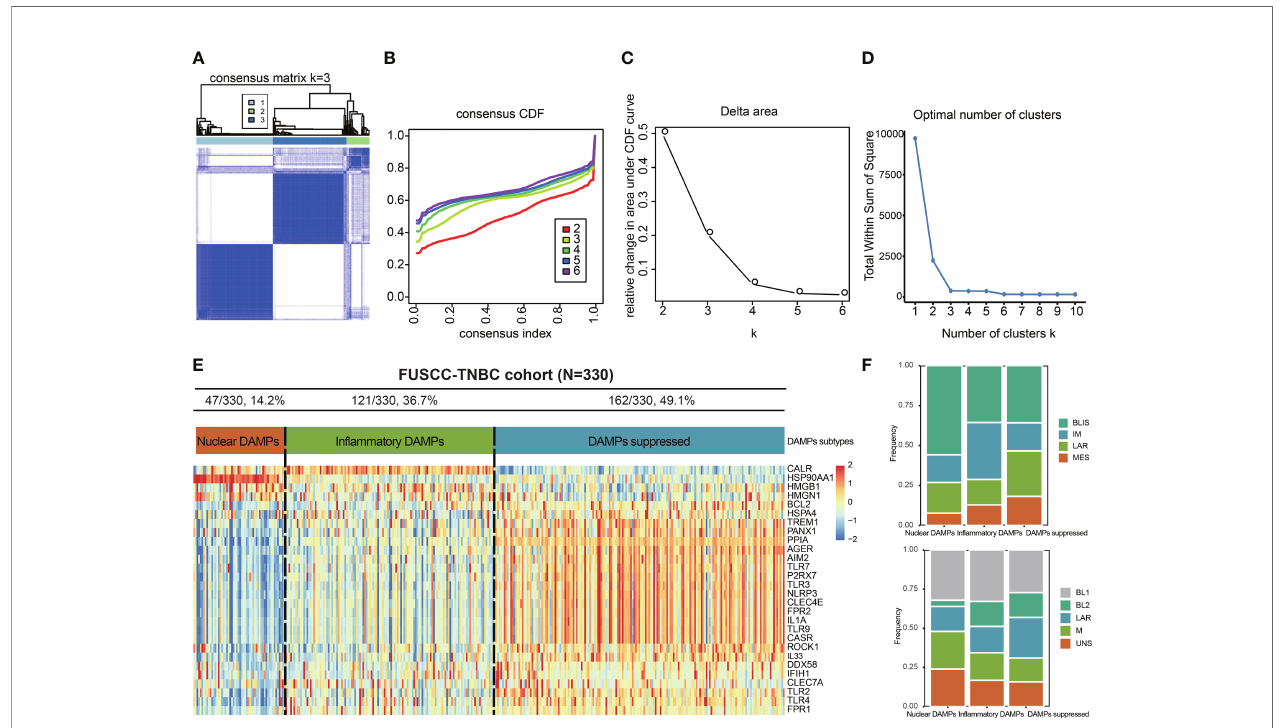
FIGURE 2 | Identi fi cation of DAMPs-associated subtypes by K-means analysis. (A-C) K = 3 was identi fi ed as the optimal value for consensus clustering. (D) K = 3 was identi fi ed as the optimal value for cluster sums of squares. (E) DAMPs-associated subtyping of TNBC samples (n = 330) in the FUSCC cohort. Heatmap shows normalized enrichment scores of the three DAMPs-associated subtypes. (F) Bar plots showing the distribution of FUSCC TNBC subtypes and Lehmann TNBC subtypes among the DAMPs-associated